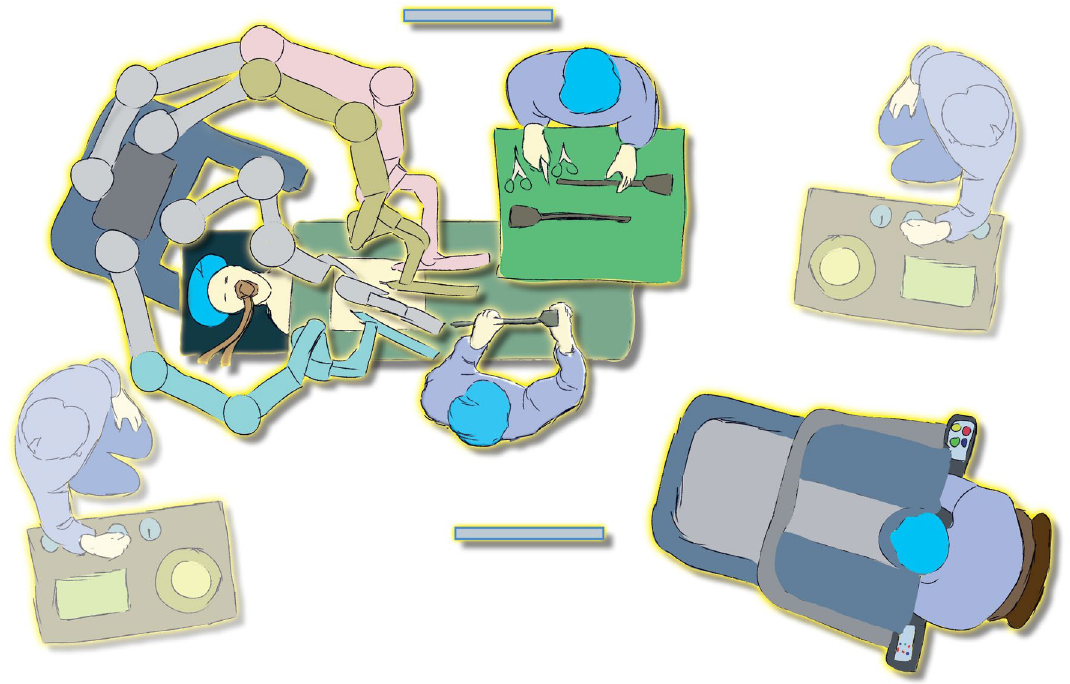
Figure 2. Operating room set-up for robotic retroperitoneal lymph node dissection (R-RPLND). We thank Thomas Gebhardt for creating the